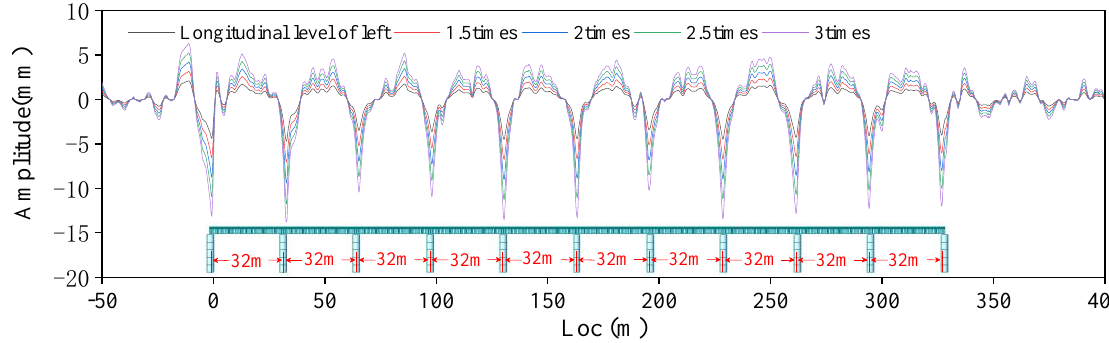
Figure 13. Track longitudinal level and times.